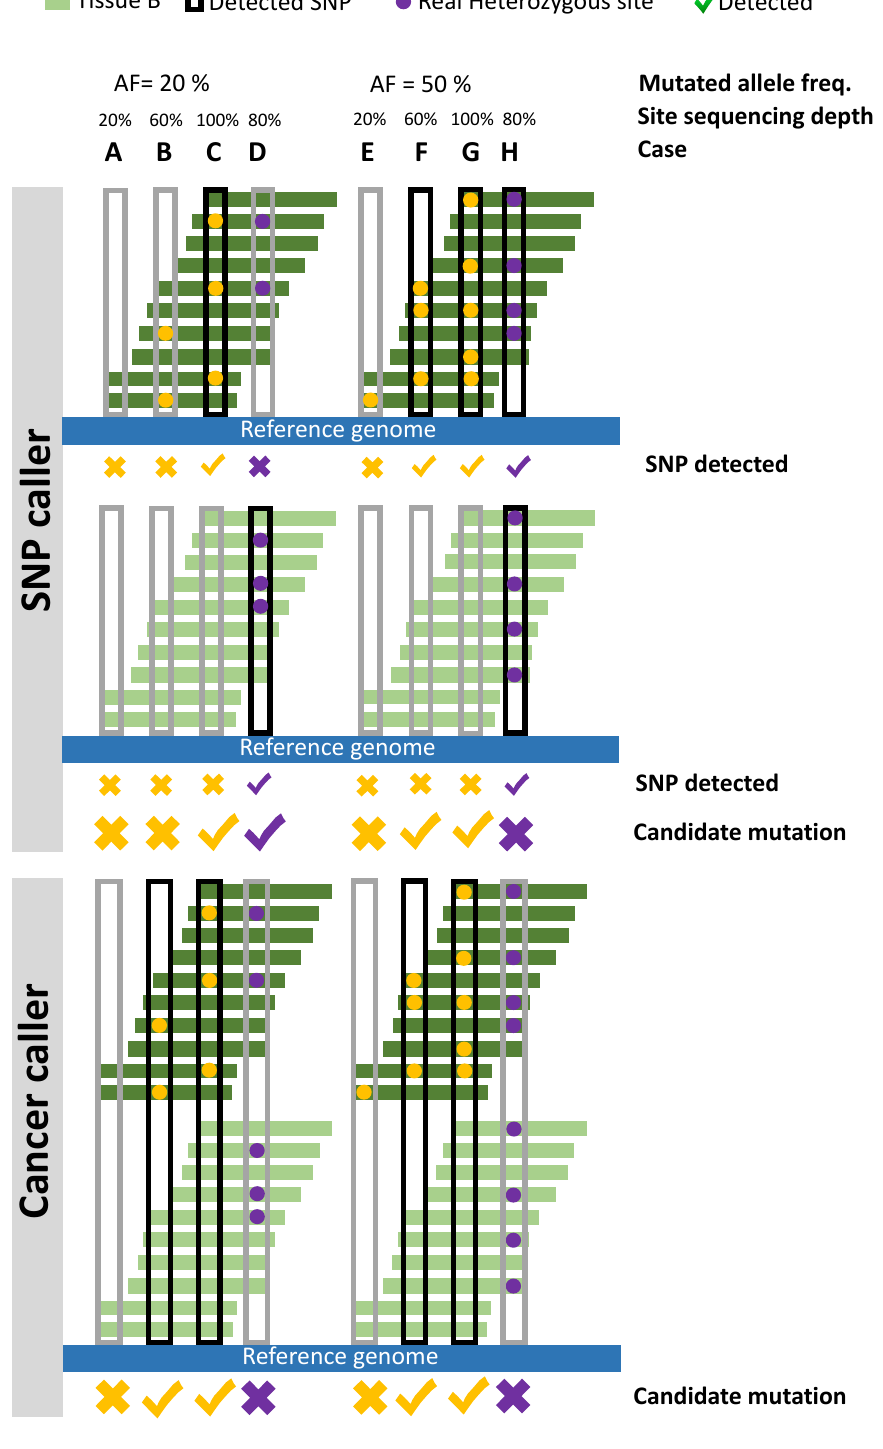
Figure 1: SNP callers (top rows) detect candidate mutations per tissue sample (dark green and light green) against the reference genome (blue) and validate the robustness of mutations by comparing results between sample pairs, while cancer callers identify mutations by comparing two samples, one mutated (tissue A, dark green) and one normal (tissue B, light green), against the reference